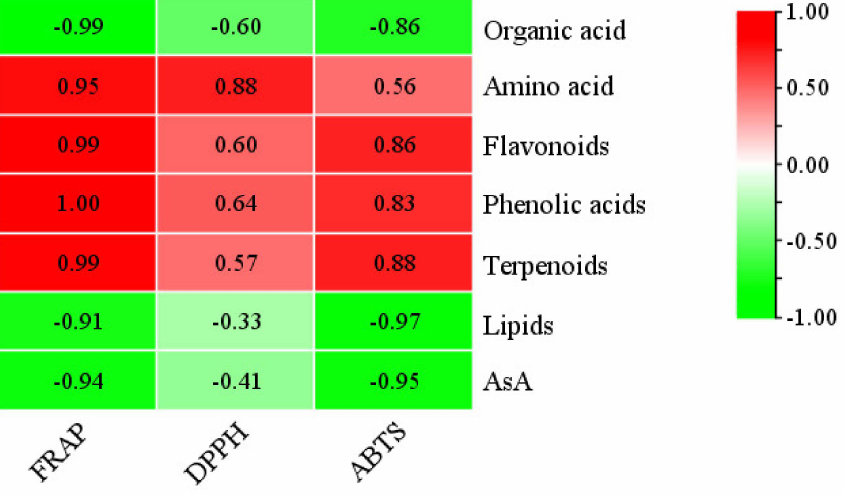
Figure 1. Correlation coefficient between active substances and antioxidant capacity. High correlation corresponds to red, and low correlation corresponds to green. When the correlation coefficient is ≥ 0.95, it is significant at the level of 0.05; when the correlation coefficient is ≥ 0.99, it is significant at the level of